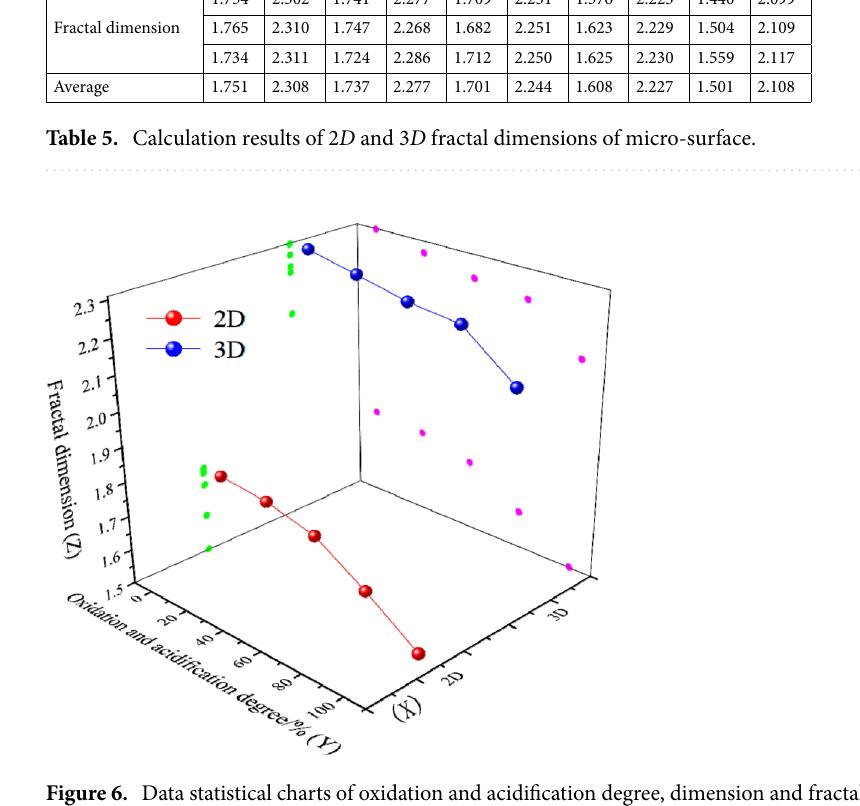
Figure 6. Data statistical charts of oxidation and acidification degree, dimension and fractal dimension.